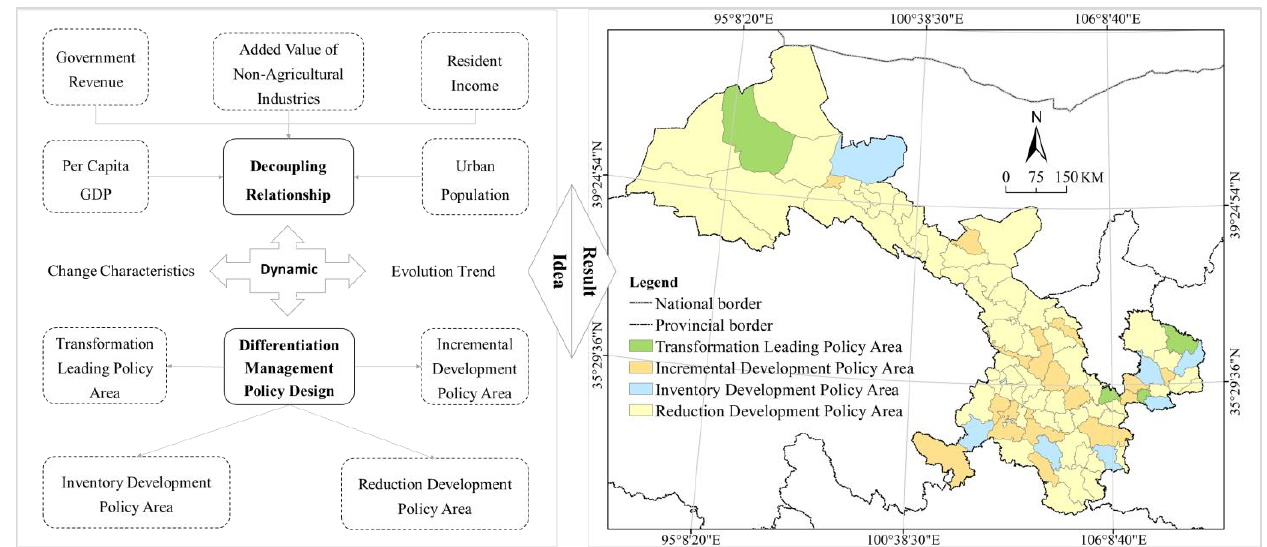
Figure 16. Analysis on the differentiated policy area in Gansu .